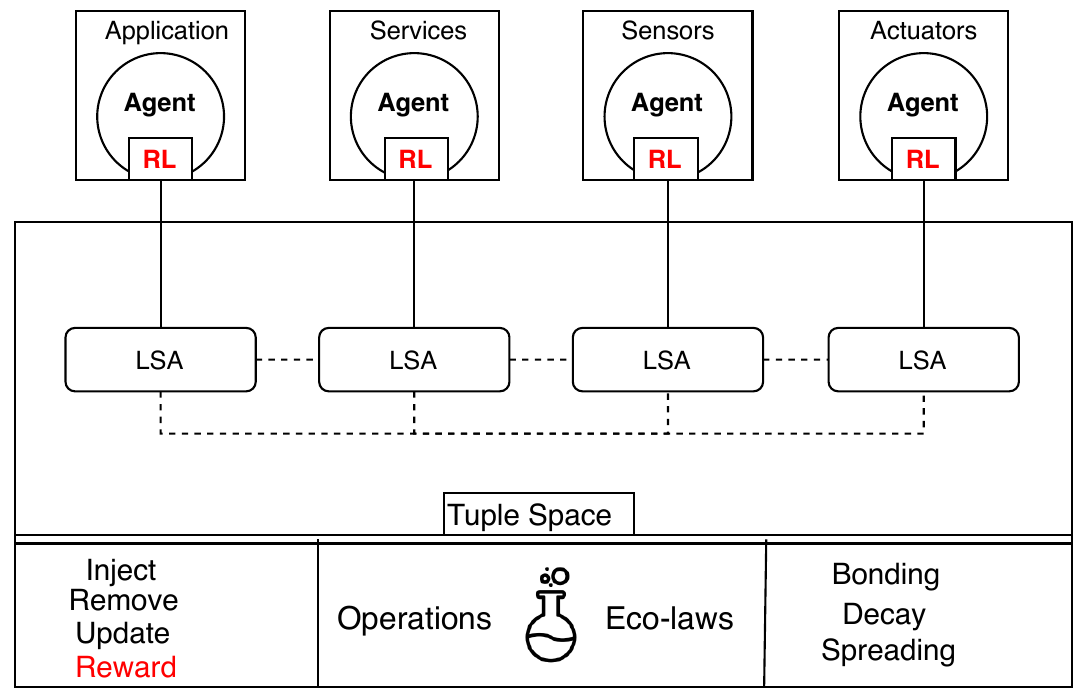
Figure 1. Learning-based coordination model (derived from the SAPERE [37] coordination